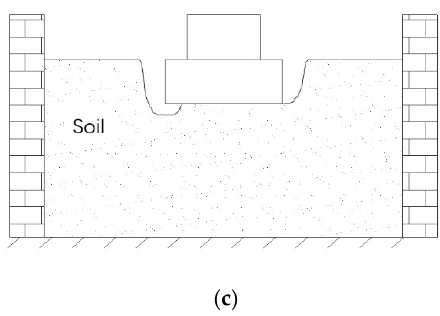
Figure 12. Changes to the soil constraint state on model S1: ( a ) soil constraint released on one side; ( b ) soil constraint released on two sides; and ( c ) soil constraints released on two sides and a corner.